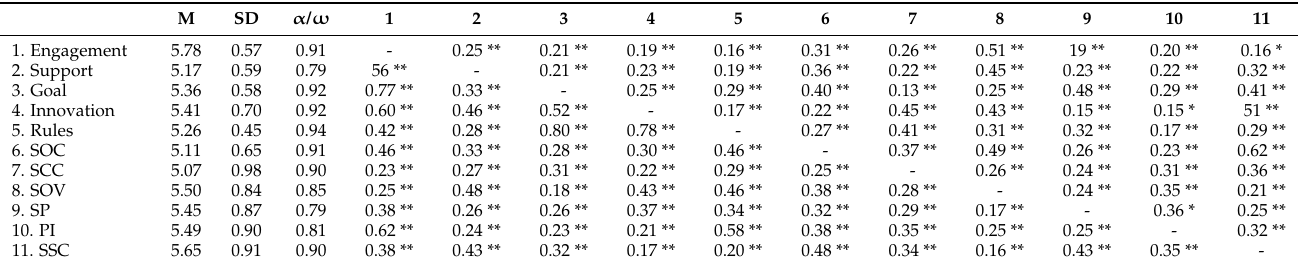
Table 2. Descriptive statistics and inter-correlations for study 1 at the individual level and at group level